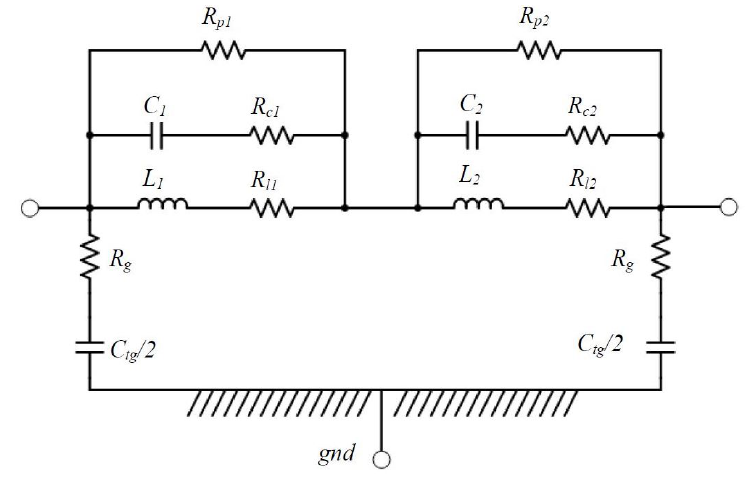
Figure 11. Three-terminal HF equivalent circuit of the coil proposed in